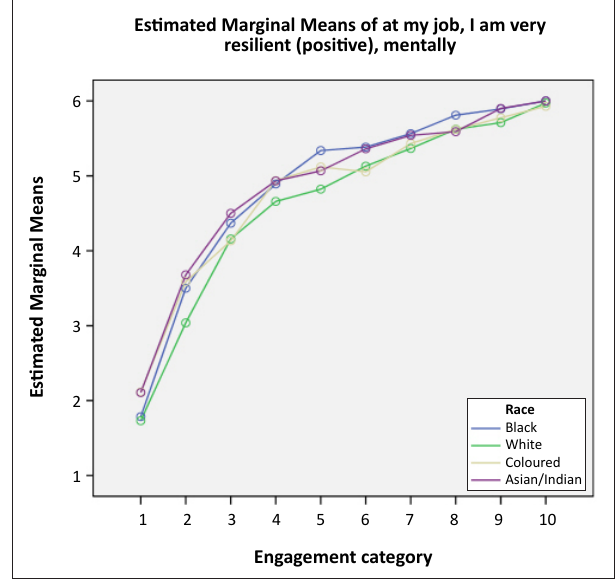
FIGURE 2: Race group mean differences in terms of engagement categories for item